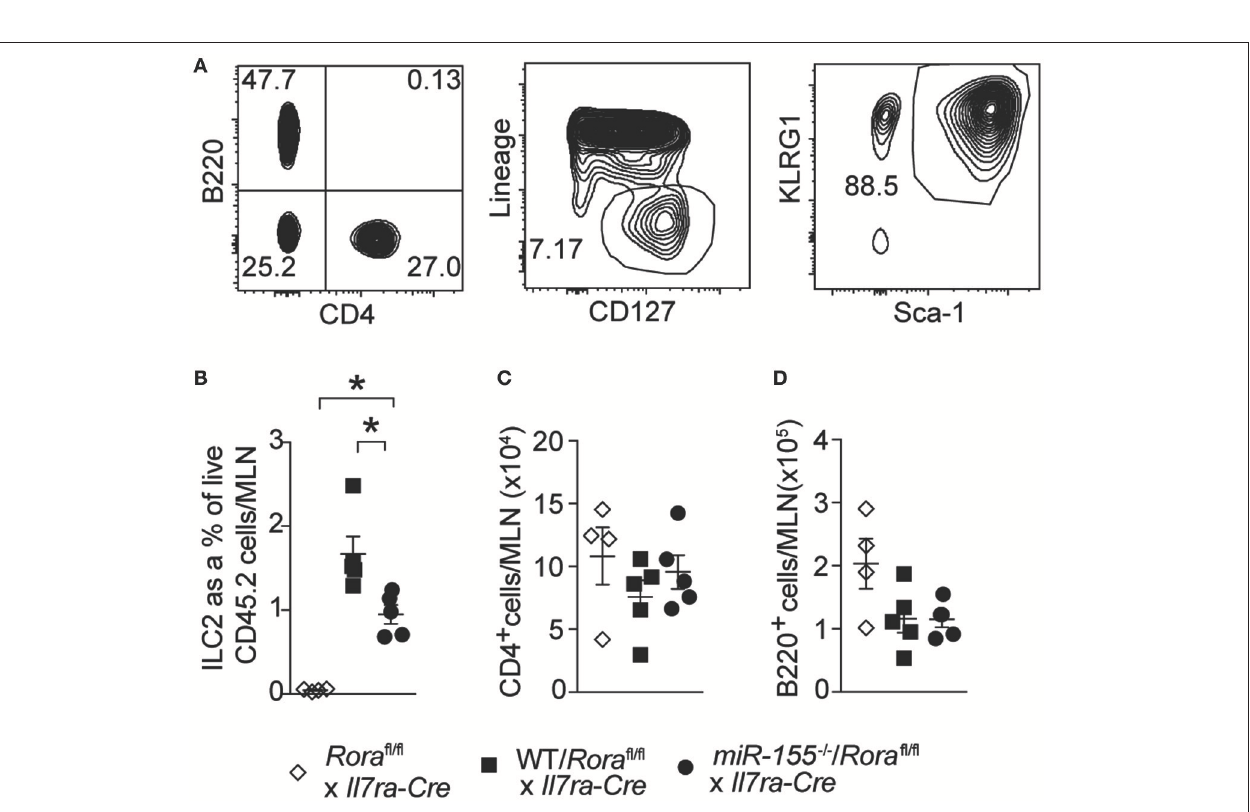
FIGURE 4 | ILC2 intrinsic miR-155 is critical for ILC2 expansion. B6SJL mice were lethally irradiated and received BM from Rora flox / flox x Il7ra Cre mice alone or in equal proportions with WT or miR155 − / − BM. After 3 months to allow reconstitution, mice were treated with i.p. IL-33 (1 ug/dose) for 3 days. (A) Representative flow cytometry gating for the indicated populations. (B) Frequency of ILC2 (Lin − CD127 + KLRG1 + Sca1 + ) from MLN. Numbers of CD4 + T cells (C) and B cells (D) from MLN. Data are representative of three independent experiments. * p ≤ 0.05 with ANOVA with Tukey correction.